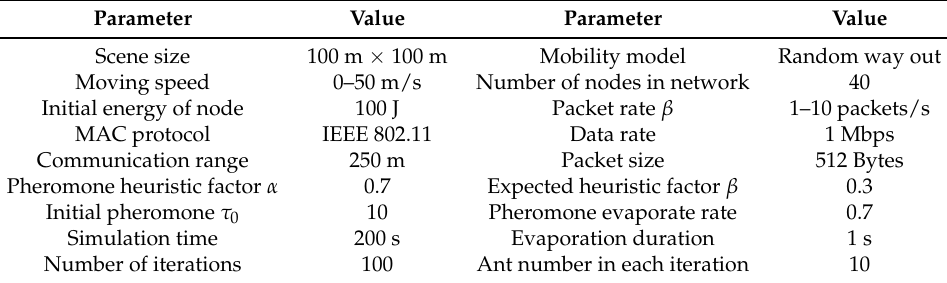
Table 4. Simulation parameters for routing